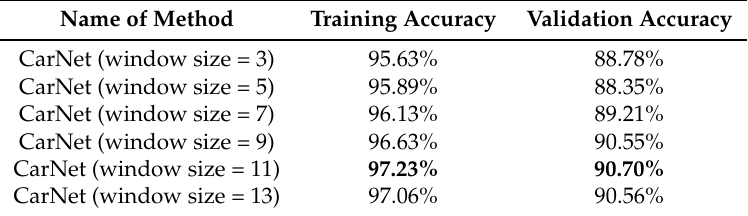
Table 7. Comparison of training and validation accuracies for experiments with different window sizes.